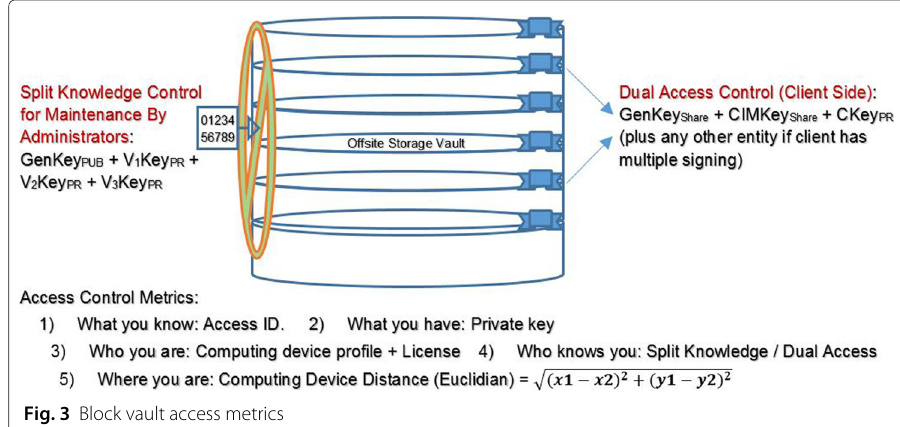
Fig. 3 Block vault access